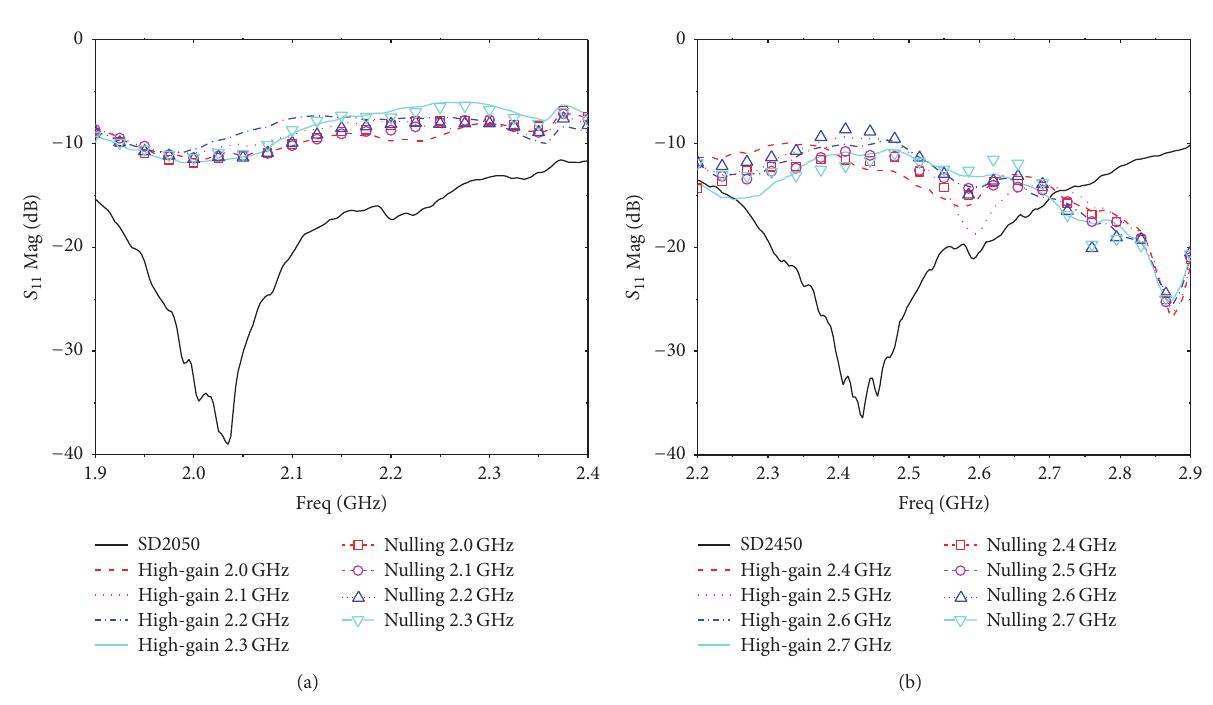
Figure 17: The influence on 𝑆 11 . (a) SD2050 and 8 modes. (b) SD2450 and 8 modes.